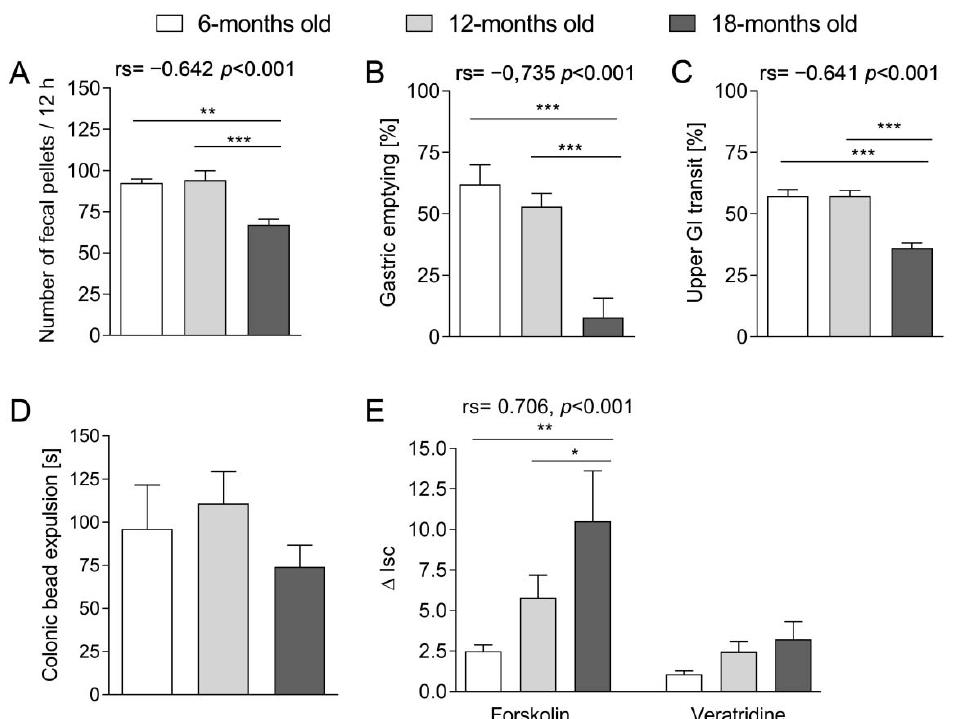
Figure 1. The evaluation of the age-related changes in the mouse GI tract. Panels from ( A – D ) present the alterations in the GI peristalsis: number of fecal pellets excreted over 12 h ( A ), gastric emptying ( B ), upper GI transit ( C ) and colonic transit ( D ) in 6-, 12- and 18-month old mice. ( E ) includes the comparison of the change in short circuit current ( ∆ I sc ) between 6-, 12- and 18 month- old mice after the stimulation with forskolin (10 − 5 M; left side of the figure) and veratridine (3 × 10 − 5 M, right side of the figure). One-way analysis of variance (ANOVA) followed by Bonferroni correction test was used to evaluate the difference between groups. Bars represent mean ± SEM. For significant association between age and given variables ( A – D ). Spearman’s rank correlation coefficient (denoted as rs) was presented. * p < 0.05, ** p < 0.01, *** p < 0.001.